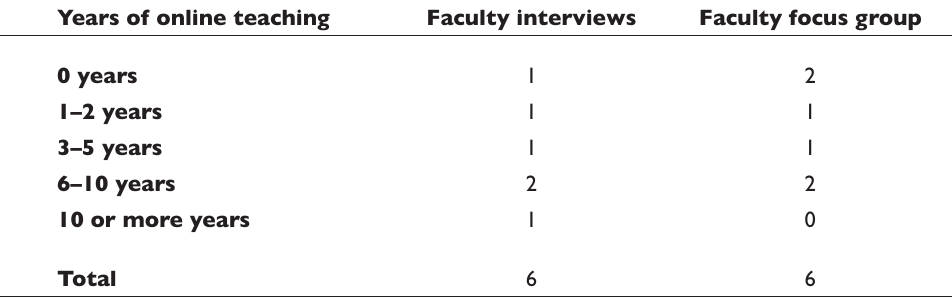
Table 1: Characteristics of teaching staff